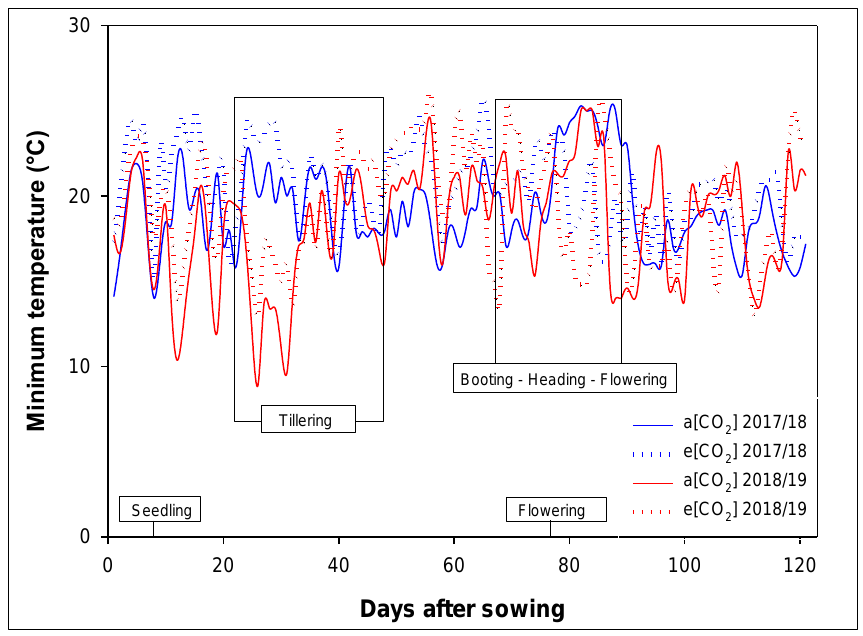
Figure 2. Average daily minimum temperatures measured inside the open-top chambers during 2017/18 and 2018/19 growing seasons maintained at two CO 2 concentrations ( a [CO 2 ] = 400 μmol mol −1 and e [CO 2 ] = 700 μmol mol −1 ). The study was conducted in Pelotas, Rio Grande do Sul State, Brazil.